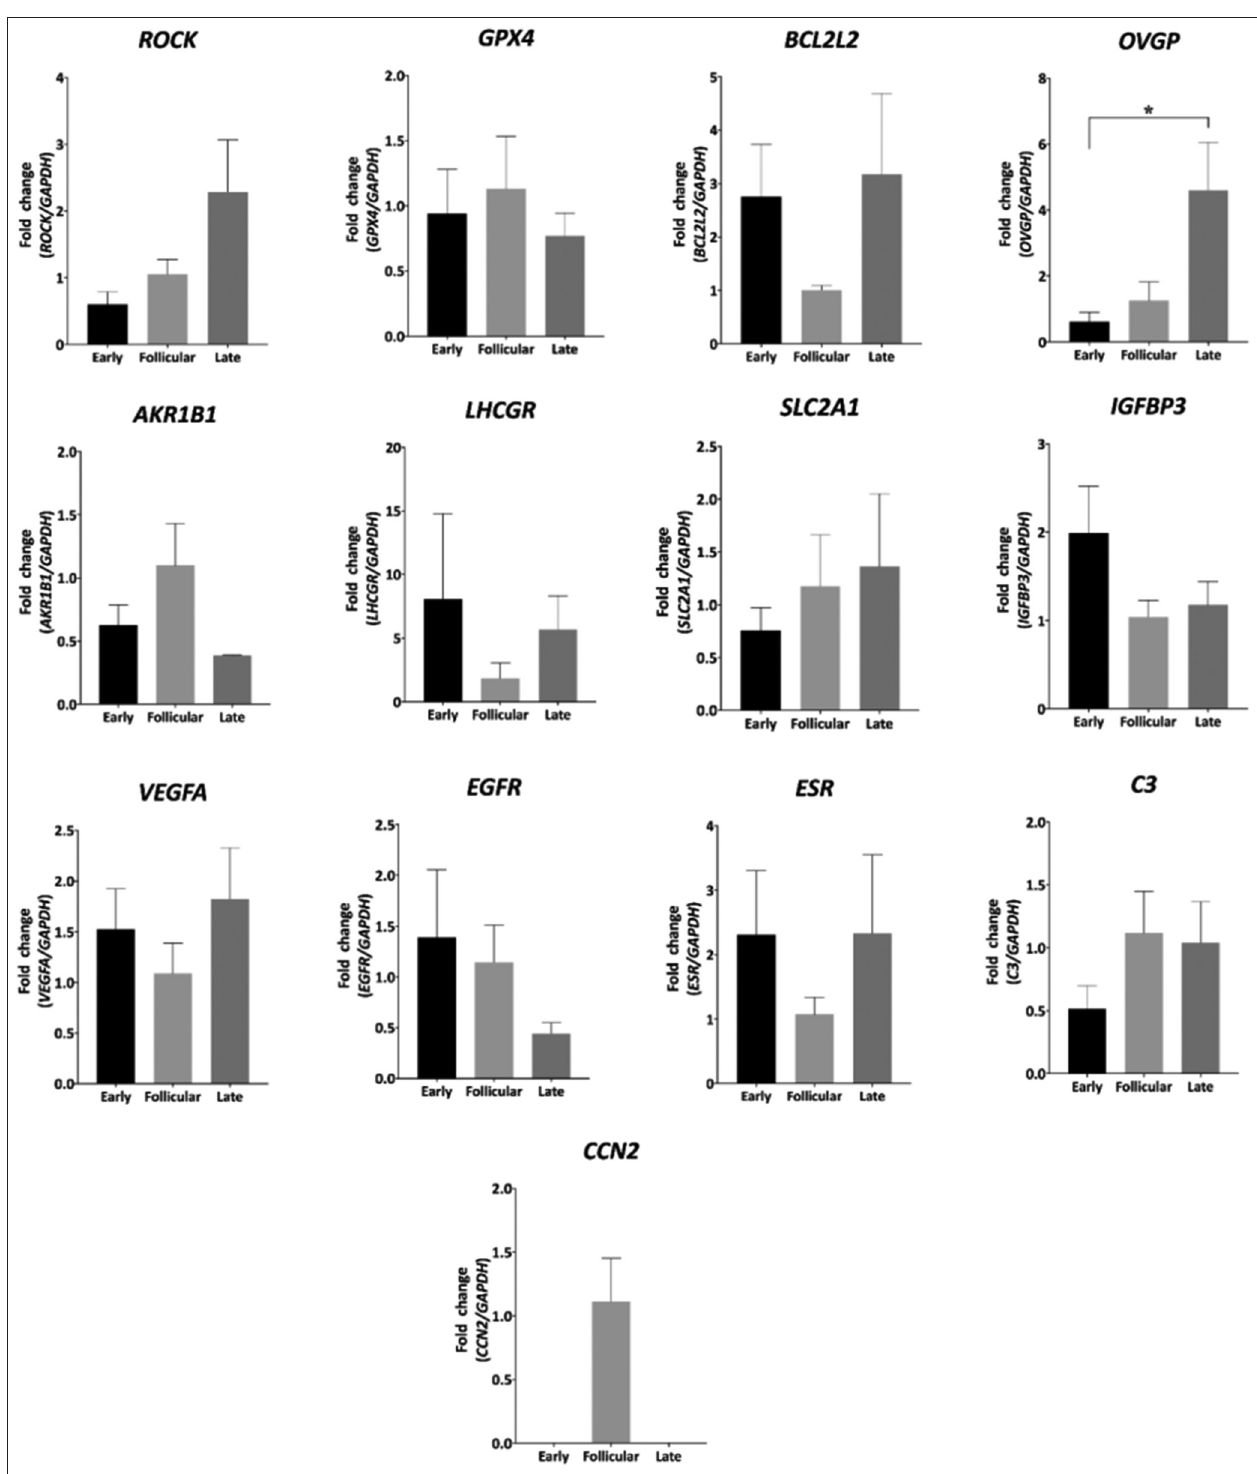
Figure-2: Gene expression patterns of different genes related to cytokinesis and mitosis mechanisms ( ROCK , rho- associated coiled-coil containing protein kinase; CCN , Cellular communication network), growth factors ( IGFBP3 , insulin- like growth factor-binding protein 3; EGFR, epidermal growth factor receptor; VEGFA , vascular endothelial growth factor A), antioxidants mechanisms ( GPX4, glutathione peroxidase 4), apoptosis ( BCL2, B-cell lymphoma 2), complement component ( C3 ), energetic metabolism ( AKRIB1 , aldose reductase gene family 1-member b1; SLC2A1 , solute carrier family 2, facilitated glucose transporter member 1), hormones receptors ( ESR, estrogen receptor; LHCGR , luteinizing hormone/ choriogonadotropin receptor), and specific glycoproteins ( OVGP , oviduct-specific glycoprotein) on oviduct isthmus, during different estrous cycle phases. Early: Early luteal phase, Late: Mid-luteal phase, Follicular: Follicular phase. Data are shown as mean ± SEM. *p < 0.05; **p < 0.01. SEM=Standard error of the